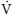
Association between aerobic capacity and emphysematous changes.The aerobic capacity at peak exercise (peak V˙
o
2) was inversely correlated with total LAA scores (p<0.0001, r = -0.485).